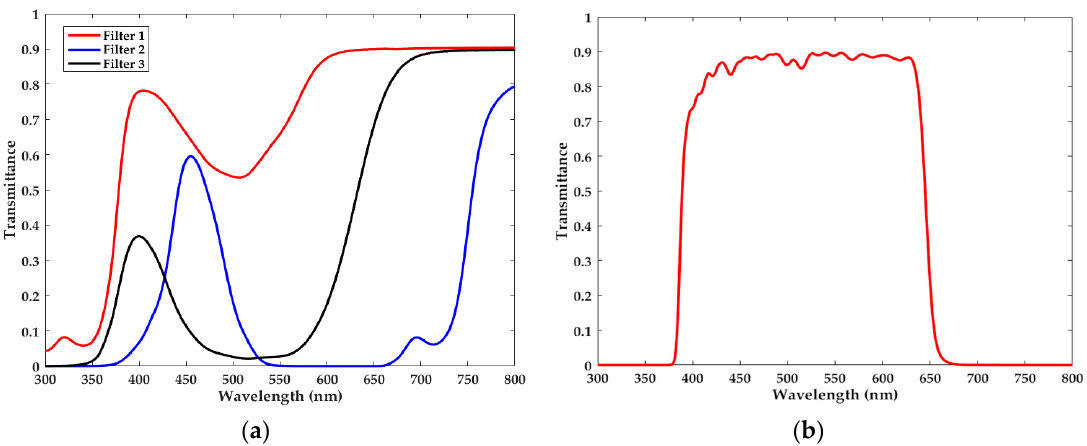
Figure 3. Transmission functions of ( a ) some filters and ( b ) the cut-off filter.